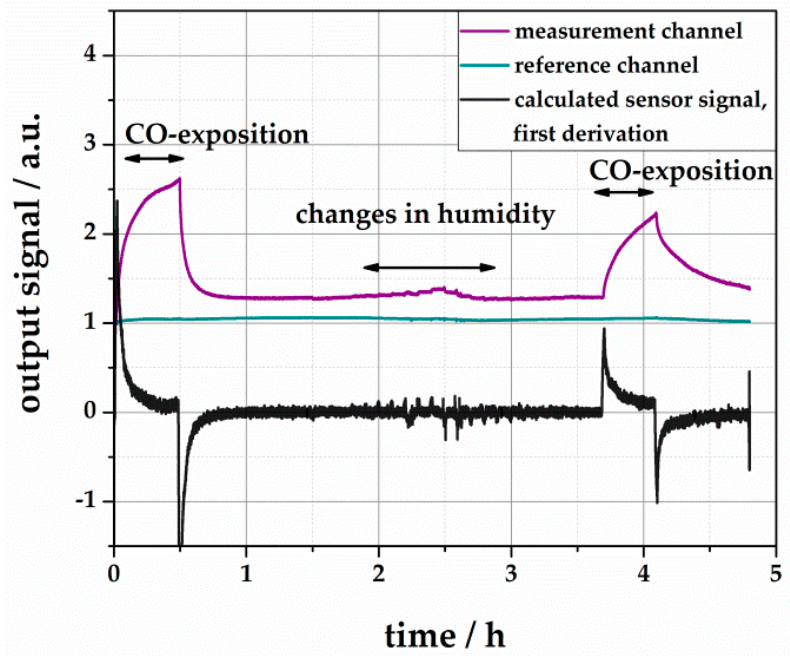
Figure 13. CO-dependent reaction of the waveguide-based sensor to 200 ppm CO and different background humidity. The signals are divided into the measurement and reference channel, as well as the calculated sensor signal. The measurement was carried out under ambient conditions.